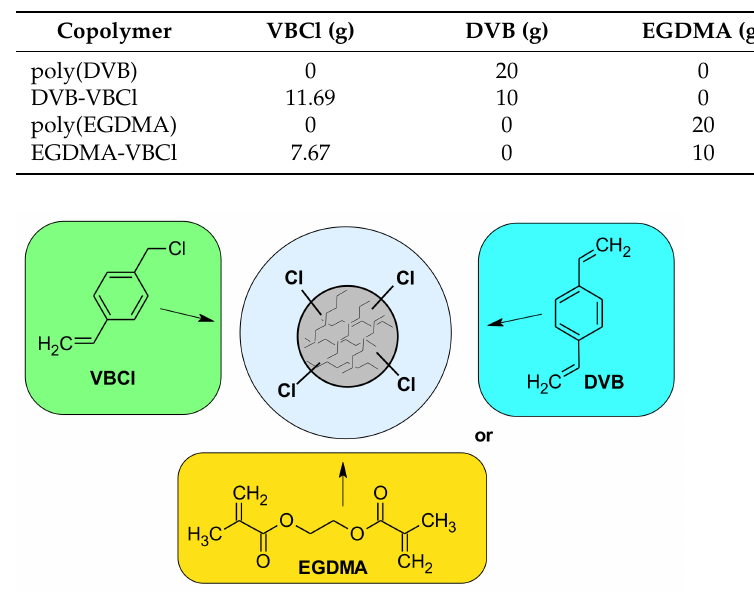
Figure 2. Chemical structure of